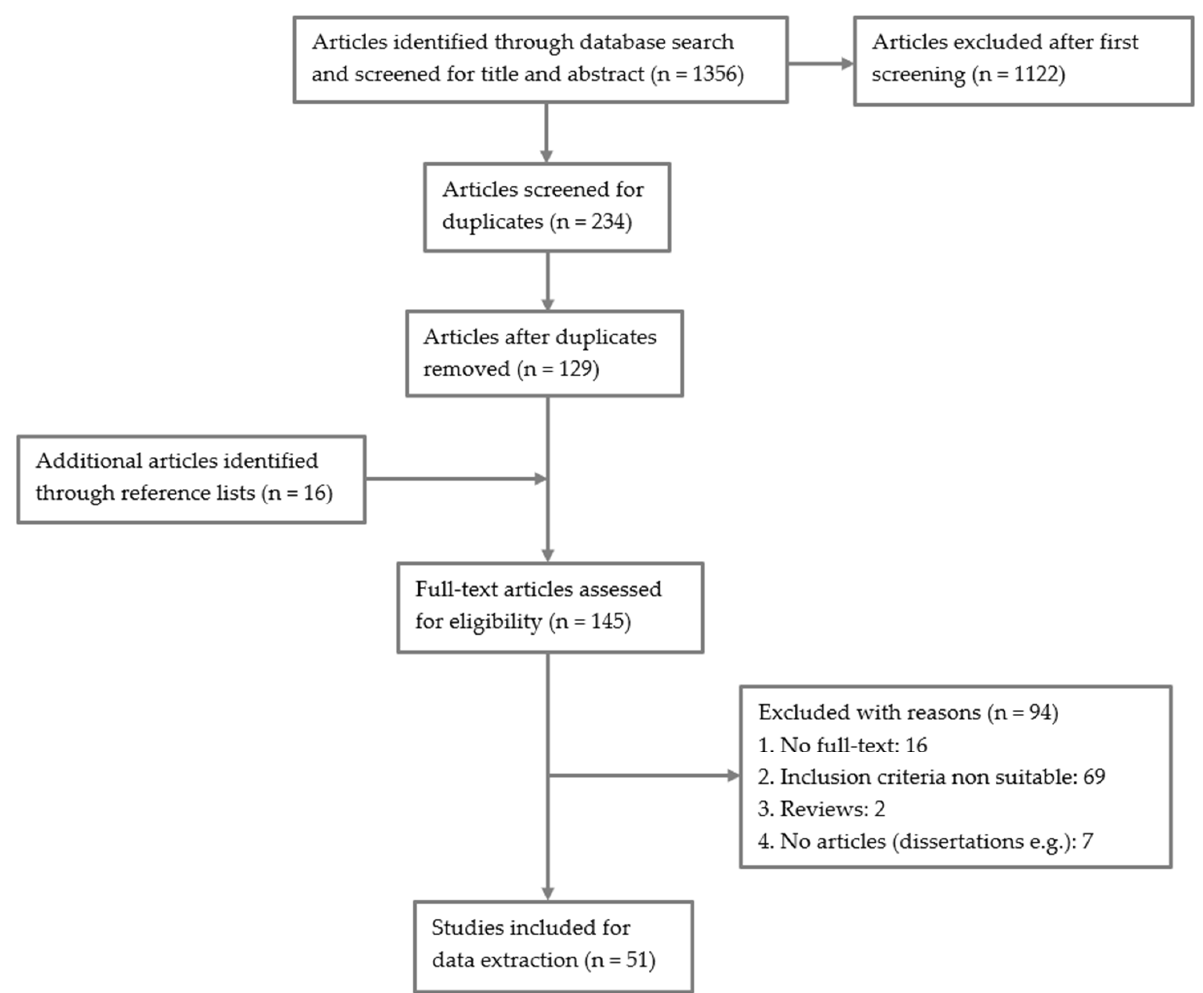
Figure 1. Search flowchart following PRISMA guidelines.